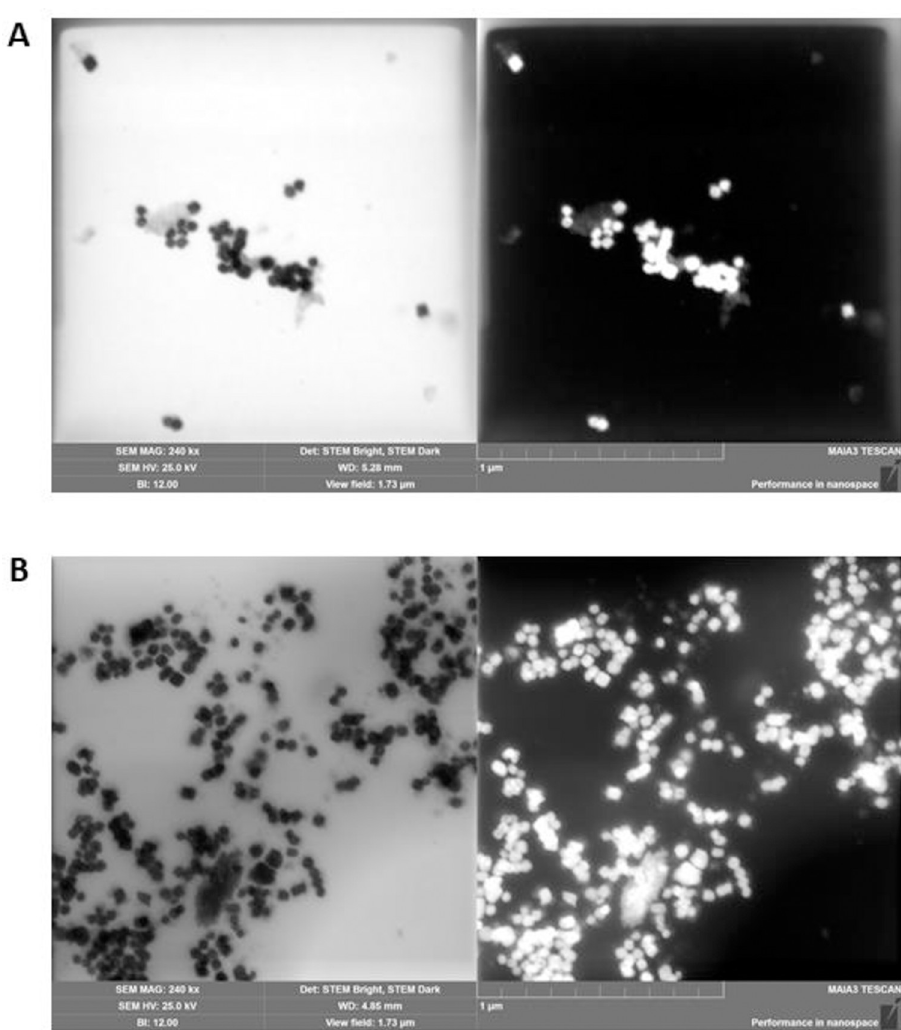
Fig 2. Bright and dark field scanning transmission electron microscope image of Harmonic Nanoparticles of Barium Titanate conjugated with ( A ) Protoporphyrin IX or ( B ) Curcumin after ultrasonication and filtration. Scale Bar– 1 μ